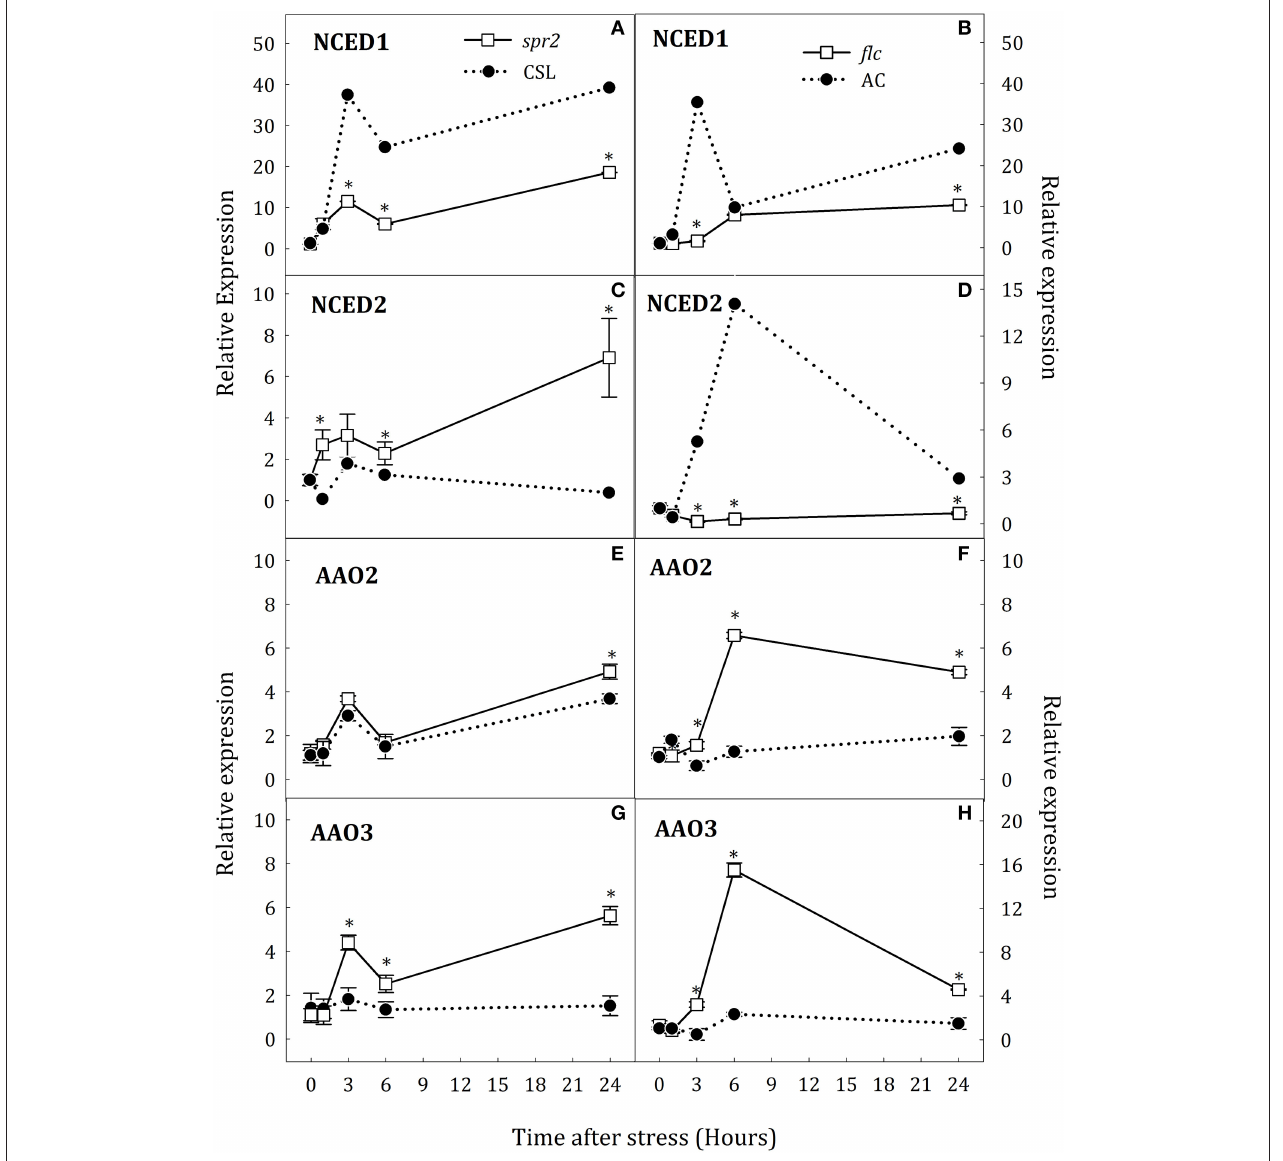
FIGURE 3 | Relative expression of NCED1 (A,B), NCED2 (C,D), AAO2 (E,F), and AAO3 (G,H) in roots of Solanum lycopersicum [WT (CSL and AC, black circles) and mutants ( spr2 and flc , white square)] under control ( t = 0 ) and water-stress conditions. Data are mean values ± standard deviation of three independent determinations. Asterisks denote statistical difference with respect to WT at p ≤ 0.05